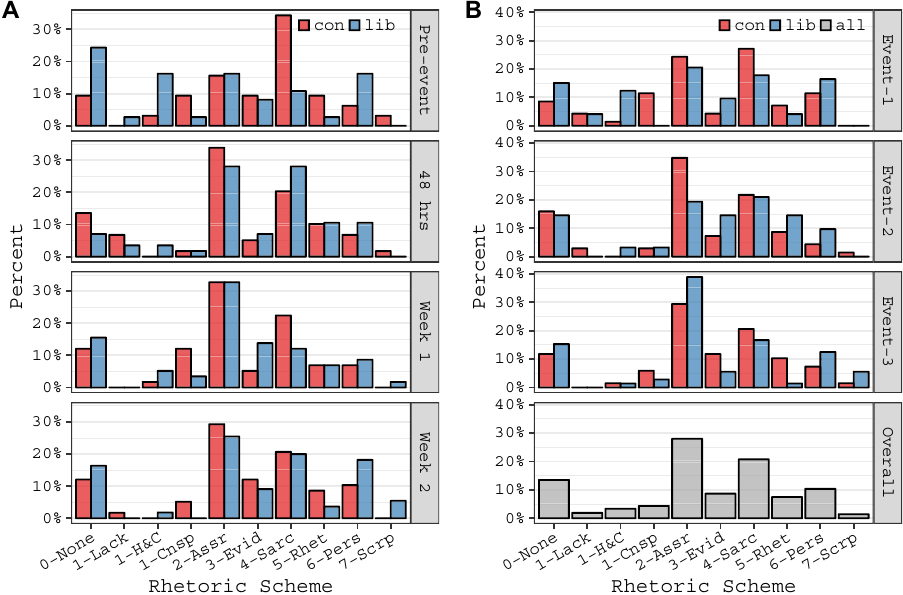
Fig. 5 The distribution of Rhetoric Scheme across (a) different stages, and (b) events. Each bar represents the proportion of the group ’ s tweets coded with the corresponding category, at each condition. The fi rst three sub-categoriesare merged into one (1-Lack) for the convenience of